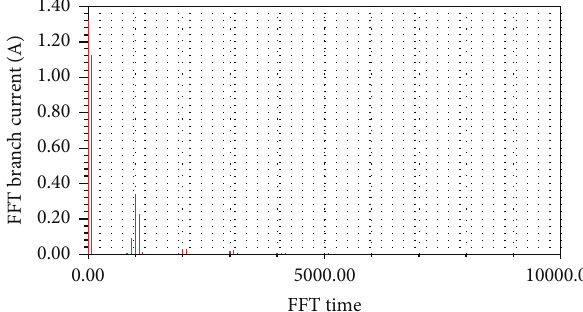
Figure 8: The FFT of DC link current (without filter). Figure 9: The FFT of DC link current (with LC filter).